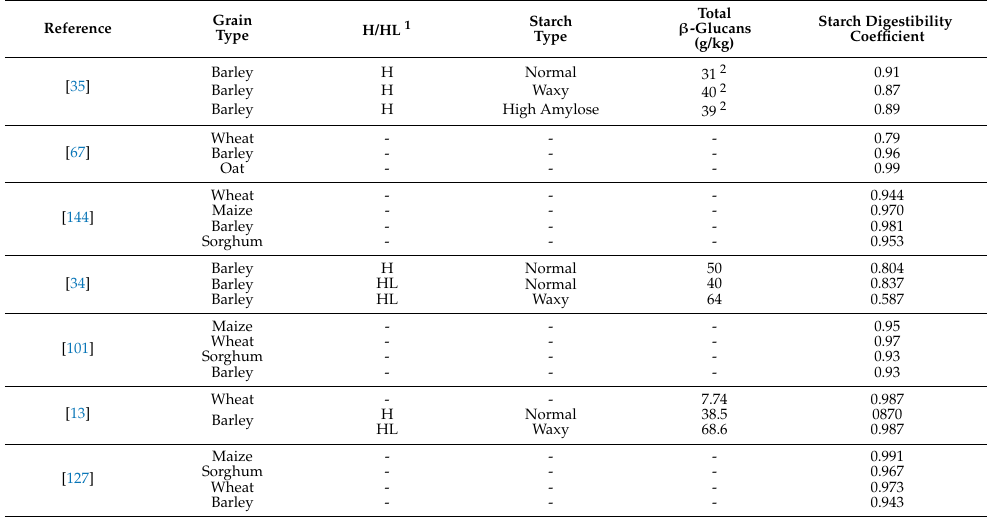
Table 8. Ileal starch digestibility of different grain types fed to